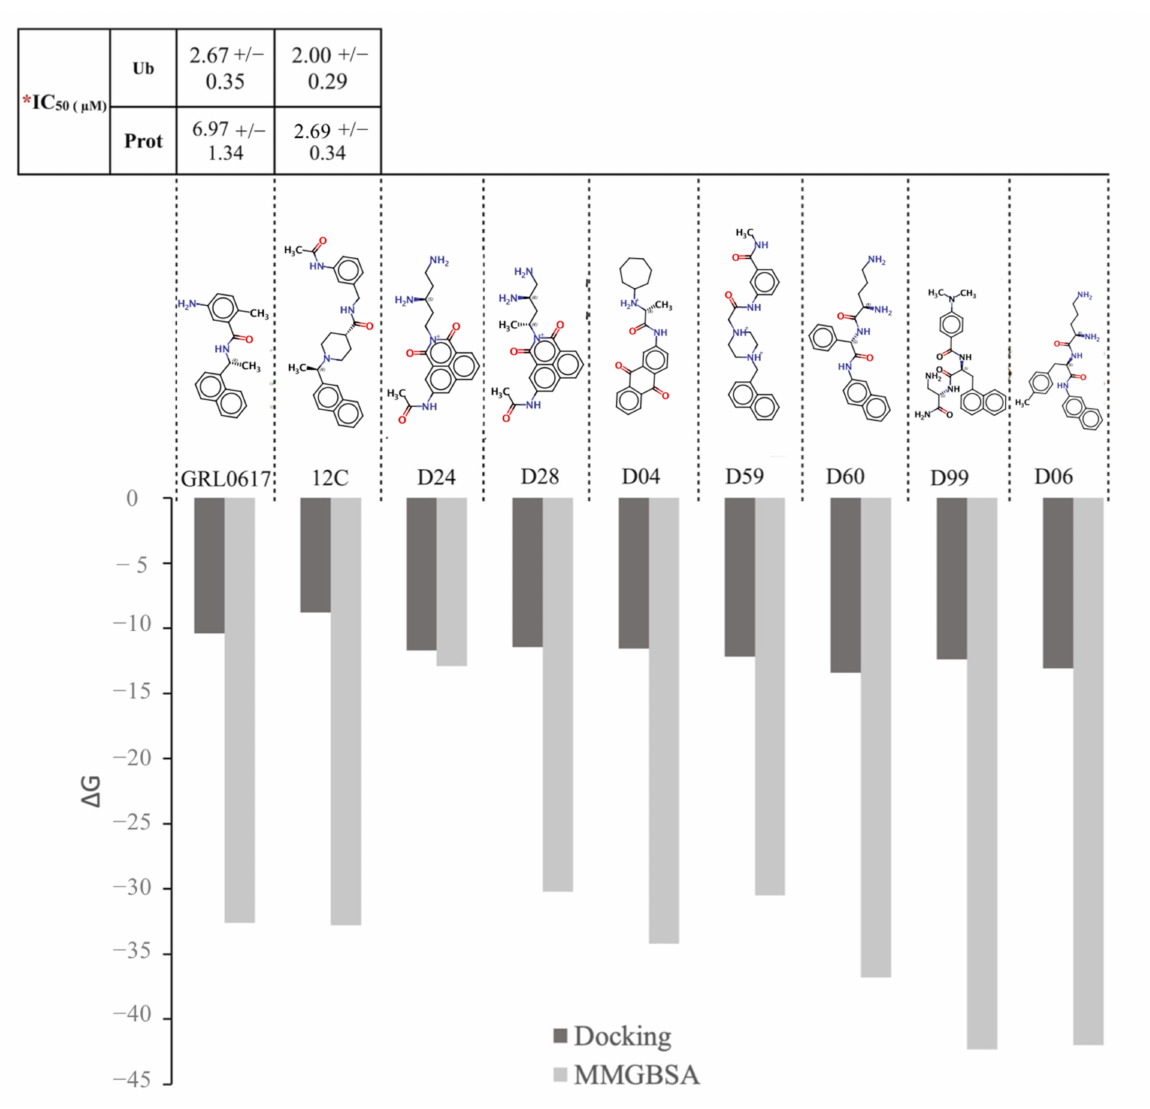
Figure 7. Free energy of binding ( ∆ G bind ) of controls (GRL0617 and 12C) and selected compounds (D24, D28, D04, D59, D60, D99, and D06) to SARS-CoV-2 PLpro. ∆ G bind was calculated by molecular docking (black bar) and MMGBSA (gray bar) for each compound. MMGBSA calculations were performed from selected structures every 10 ns over the last 100 ns of the simulation. For each ligand, its chemical structure is highlighted, and for the controls, the IC50 is reported in the literature. * IC 50 obtained from